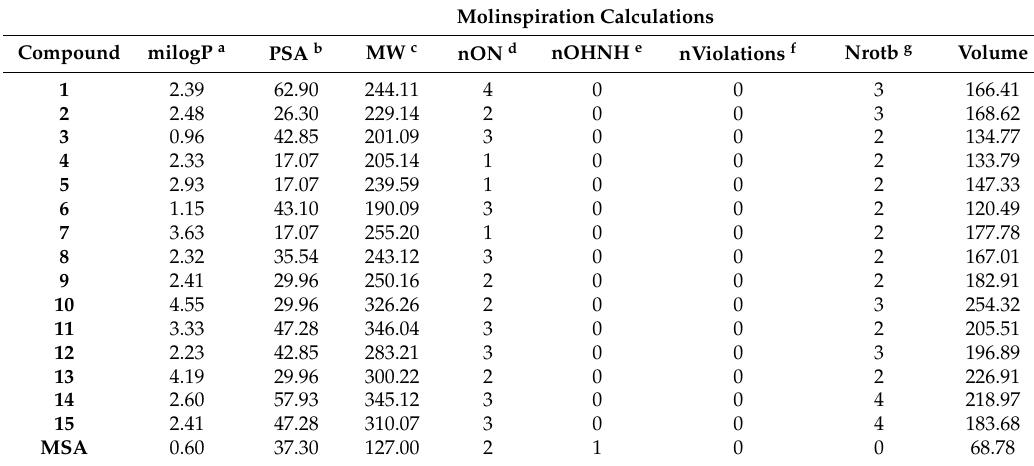
Table 2. Theoretical calculations of molecular properties based in Molinspiration calculations.